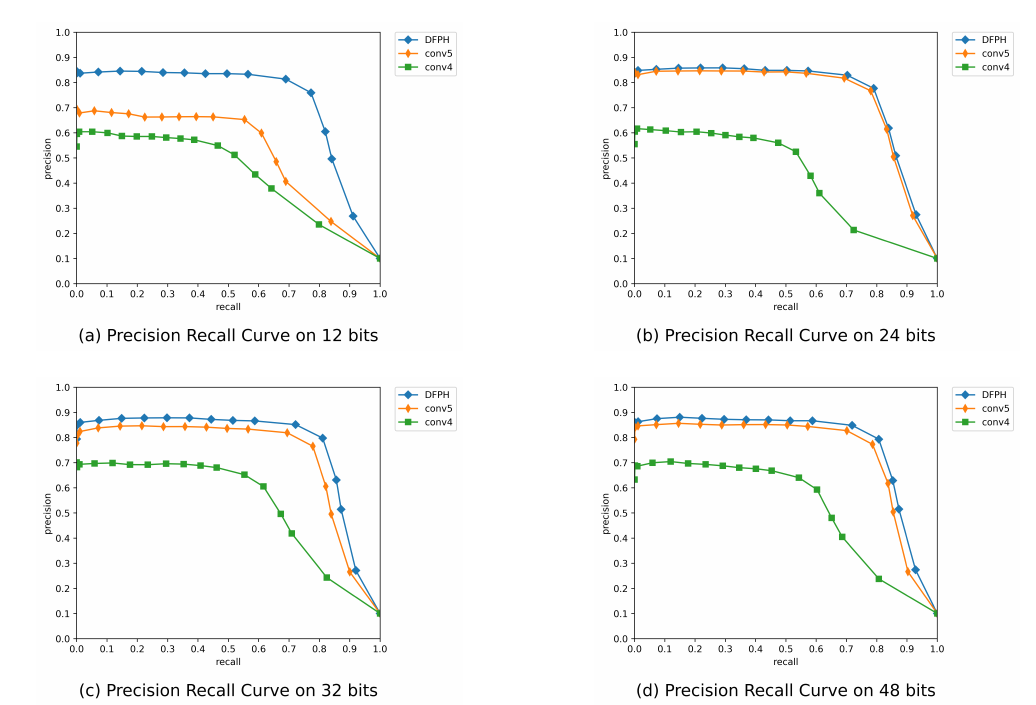
Figure 5. Precision–recall curve of different scales features on CIFAR-10 with hash bits 12, 24, 32 and